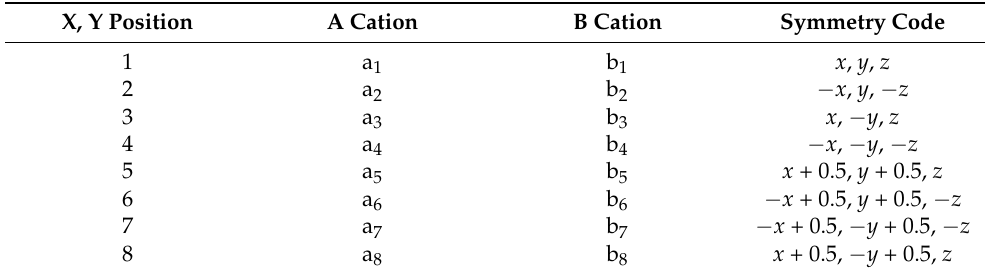
Table 1. X, Y Wyckoff position, 8 j , for atoms in A and/or B types of TMA cation, respectively.